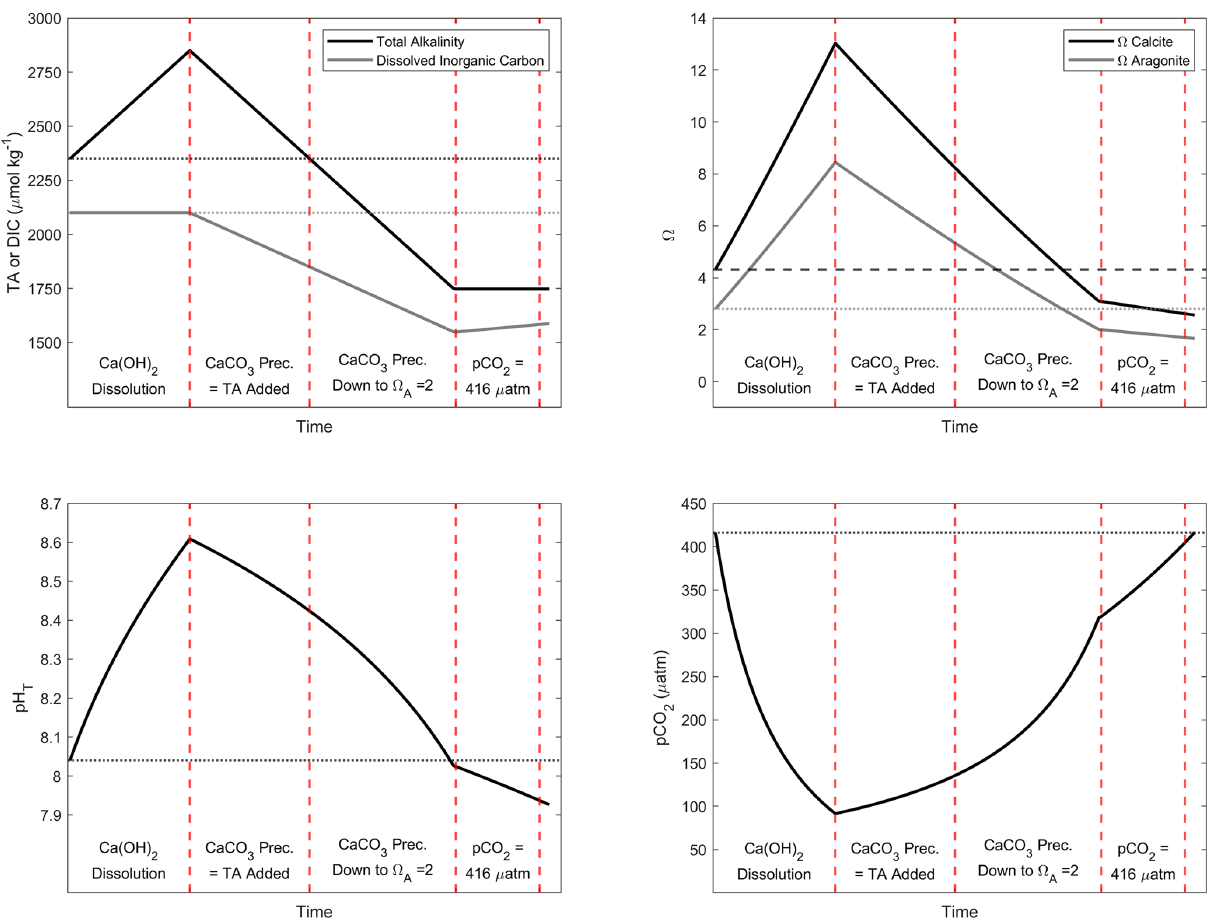
Figure A3. Simulation of the changes in TA, DIC, (cid:127) C , (cid:127) A , p CO 2 and pH T after addition of 500µmolkg − 1 of alkalinity. Four important steps are presented: first, assuming the complete Ca(OH) 2 dissolution without CaCO 3 precipitation; second, assuming as much CaCO 3 precipitation as the amount of TA added; third, assuming CaCO 3 precipitation happening until reaching an (cid:127) A of 2; and fourth, CO 2 uptake until equilibrium is reached between atmosphere and seawater at a p CO 2 of ∼